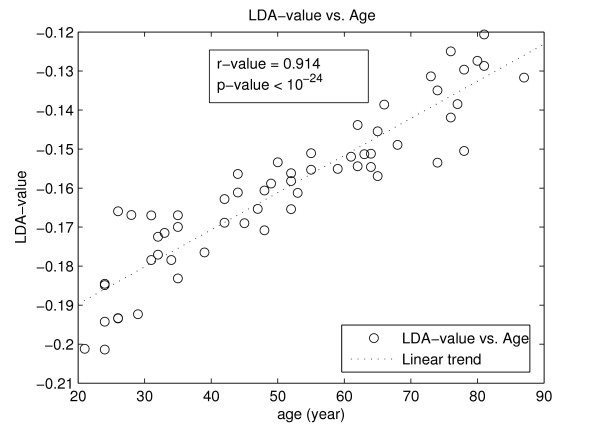
Graph of age (years) vs. the LDA-value. The graph shows the linear trend of the LDA-value with age, highlighting the strong correlation between them as suggested by the r and p-values.